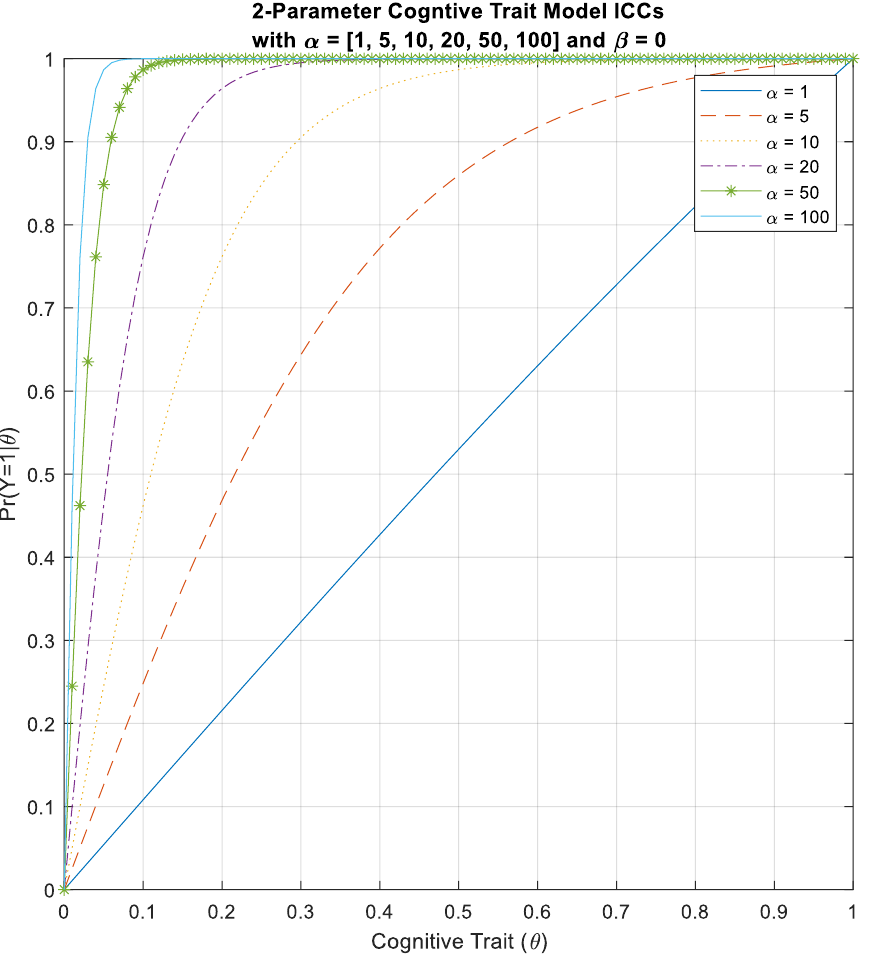
Figure 1. The top panel illustrates 2-Parameter Cognitive Trait Model Item Characteristic Curves (2P CTM ICCs) over different β values (0, 0.1, 0.2, 0.3, 0.4, 0.5, 0.6, 0.7, 0.8, 0.9, 1) when α = 10. The bottom panel illustrates 2P CTM ICCs over different α values (1, 5, 10, 20, 50, 100) when β = 0. The second technical facet is the CTM discrimination parameter α j , which describes how well an item can differentiate between the people with traits below the item location and those with traits above the item location. Figure 2 depicts 2P CTM link function based on Equation (13), showing the different item discriminations. As with the traditional IRTMs, the discrimination parameter of the proposed model also reflects the steepness of the link function, such that the greater the value of α j , the steeper the curve, and hence the better the item can discriminate at that location along the θ continuum. Conversely, the lower the value of α j , the flatter the curve, and hence the less effectively the item can dis- criminate, because the probability of a correct response at low trait levels is similar to that at high trait levels.